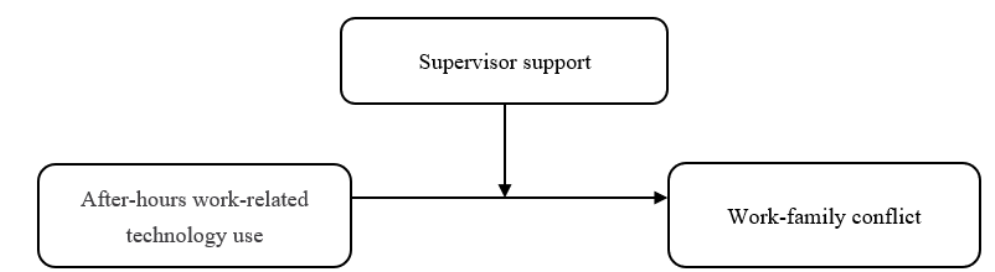
Figure 1. Relationship between after-hours work-related technology use, supervisor support, and work–family conflict.